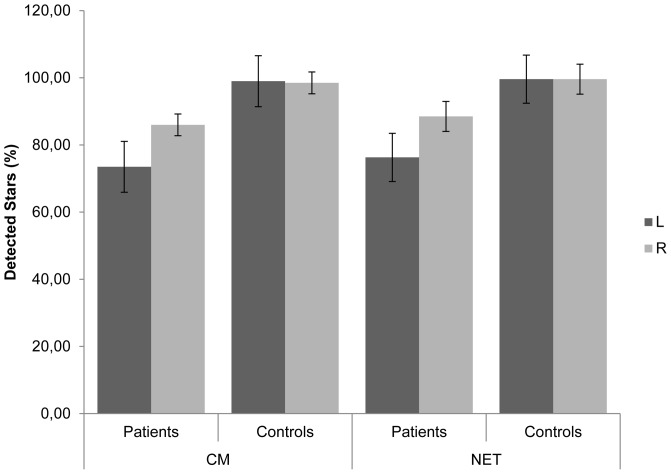
Star Cancellation Test: Percentage of detected stars, split into test-system, experimental group and visual field.The figure shows means and standard errors. Best possible performance (100%) in NET was 27 stars, in CM 20 stars per side. CM: Circle-Monitor, NET: Neglect-Test.